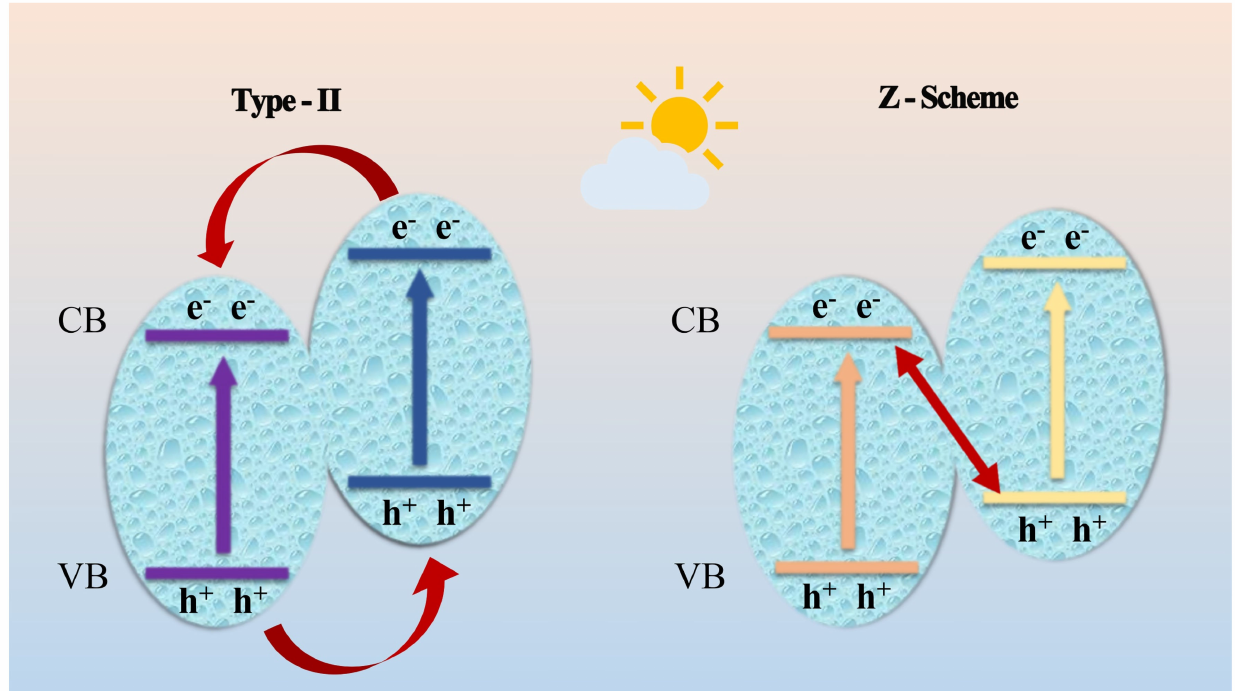
Figure 11. The electrons and holes transfer paths of two